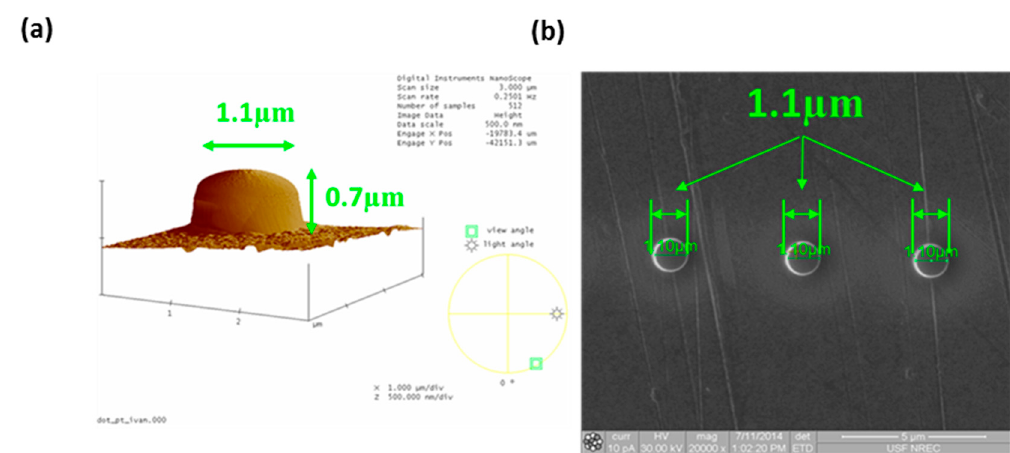
Figure 7. ( a ) A high-resolution AFM scan of FIB deposited Pt/Ga micro-pellet; ( b ) a high-resolution SEM image multiple FIB micro-pellets showing great repeatability and fabrication